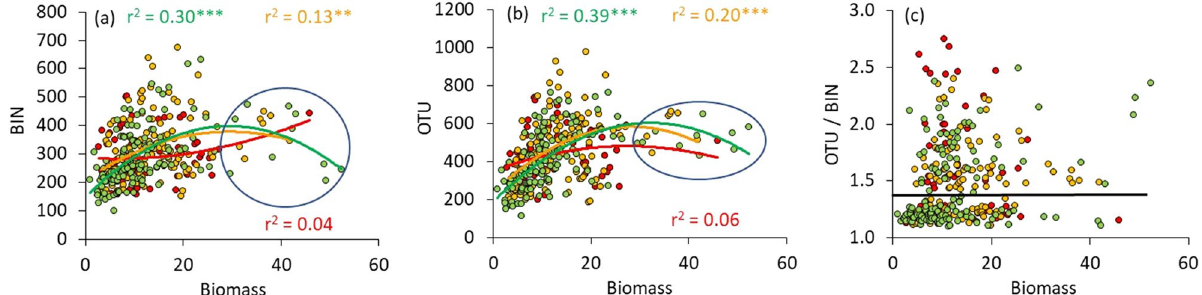
Figure 1. Relationships between numbers of BINs ( a ), OTUs ( b ), OUT/BIN ( c ) and total biomass. Green data points: organic farming, orange: recent change from conventional to organic farming, red: conventional farming. Quadratic least squares regression lines in ( a , b ) (with respective coefficients of determination r 2 ) peak between 25 and 28 g (except for BINS of conventional farming in a ). Above the 25 g threshold numbers of BINs and OTUs tend to decrease with increasing biomass (marked by ovals). The black line in ( c ) divides data mainly from 2019 (above) and those obtained in 2020